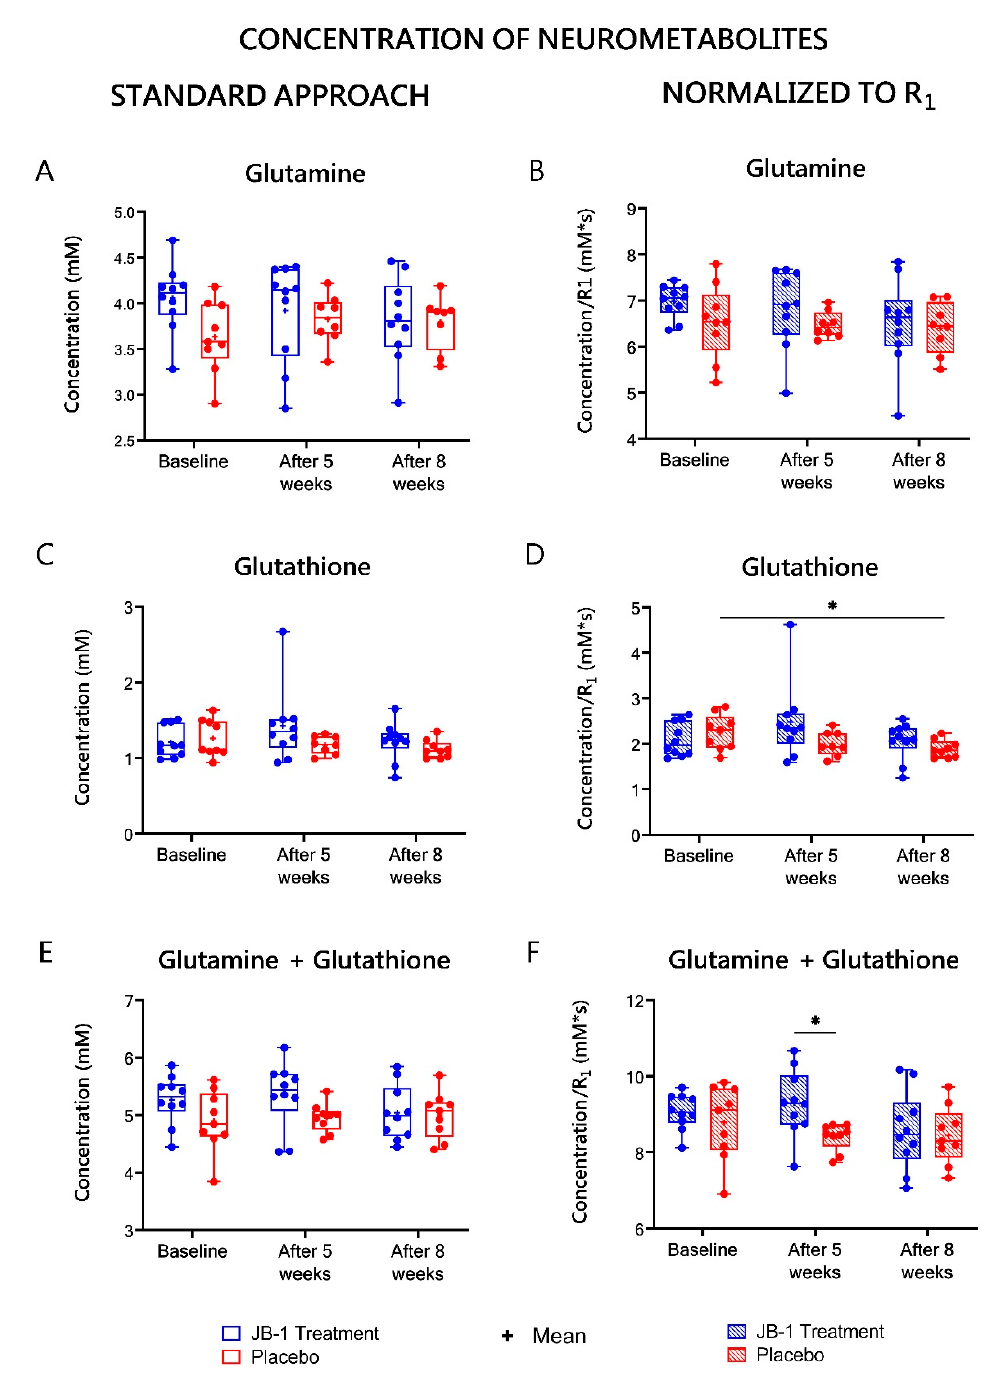
Figure 6. Hippocampal glutamine ( A ), glutathione ( C ), and glutamine + glutathione ( E ) levels calculated using typical water referencing (standard approach)—left column. Hippocampal glutamine ( B ), glutathione ( D ), and glutamine + glutathione ( F ) levels normalized to R 1 —right column. Neurometabolites’ concentrations were assessed by MRS in JB-1 treatment and placebo groups at baseline and after five and eight weeks stress protocol. Data are presented as median ± min/max. * p < 0.05; two-way ANOVA analysis for repeated measures with a post-hoc Duncan’s test.